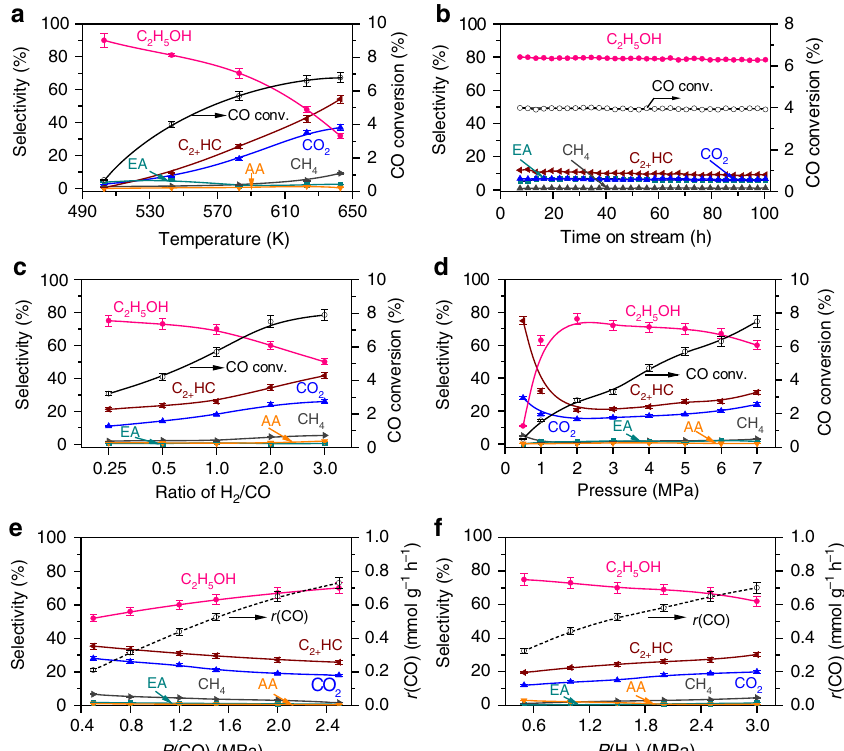
Fig. 4 Reaction kinetics for the triple tandem system. a Effect of reaction temperature. Reaction conditions: H 2 /CO = 1:1; P = 5.0 MPa; F = 25 mL min − 1 ; time on stream, 20 h. b Catalyst stability. Reaction conditions: H 2 /CO = 1:1; P = 5.0 MPa; F = 25 mL min − 1 ; T = 543 K. c Effect of H 2 /CO ratio. Reaction condition: P = 5.0 MPa; F = 25 mL min − 1 ; T = 583 K; time on stream, 20 h. d Effect of total pressure. Reaction condition: H 2 /CO = 1:1; F = 25 mL min − 1 ; T